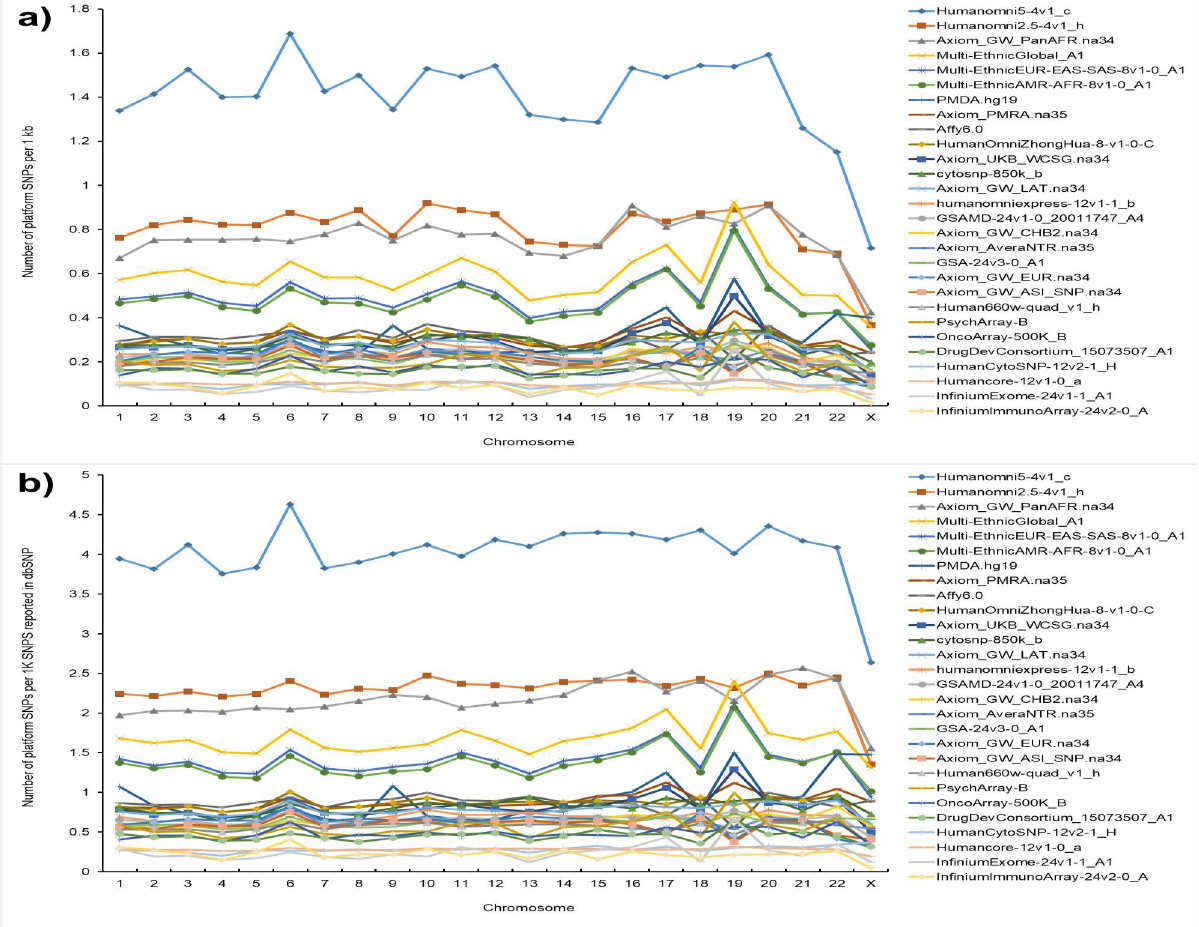
Fig 3. SNP coverage of individual human chromosomes on common genotyping platforms. (a) The number of SNPs on the platform per 1kb of the chromosomal sequence. (b) The number of SNPs on the genotyping platform per one thousand of the SNPs reported by dbSNP database for a given